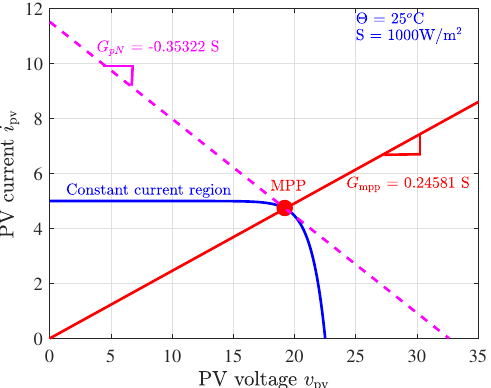
v characteristic and its linear approximation (dashed) at the MPP Figure 4. The BP585PV module i − for S = 1000 W/m 2 and Θ = 25 ◦ C. The load line of the optimum conductance G mpp = 0.2524 S and the Norton equivalent conductance G pN = 0.35322 S are also